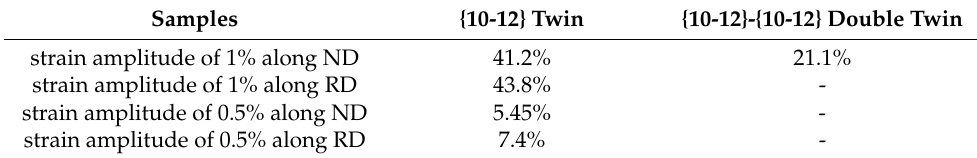
Table 2. The volume fractions of different twins in Figure 3. Samples strain amplitude of 1% along ND strain amplitude of 1% along RD 43.8% - strain amplitude of 0.5% along ND - strain amplitude of 0.5% along